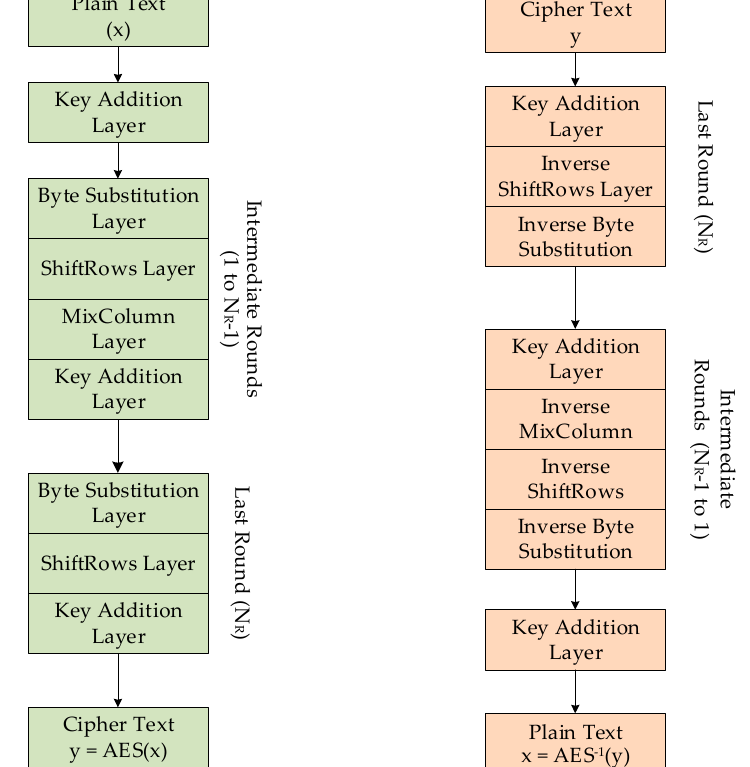
Figure 3. AES encryption and decryption process.